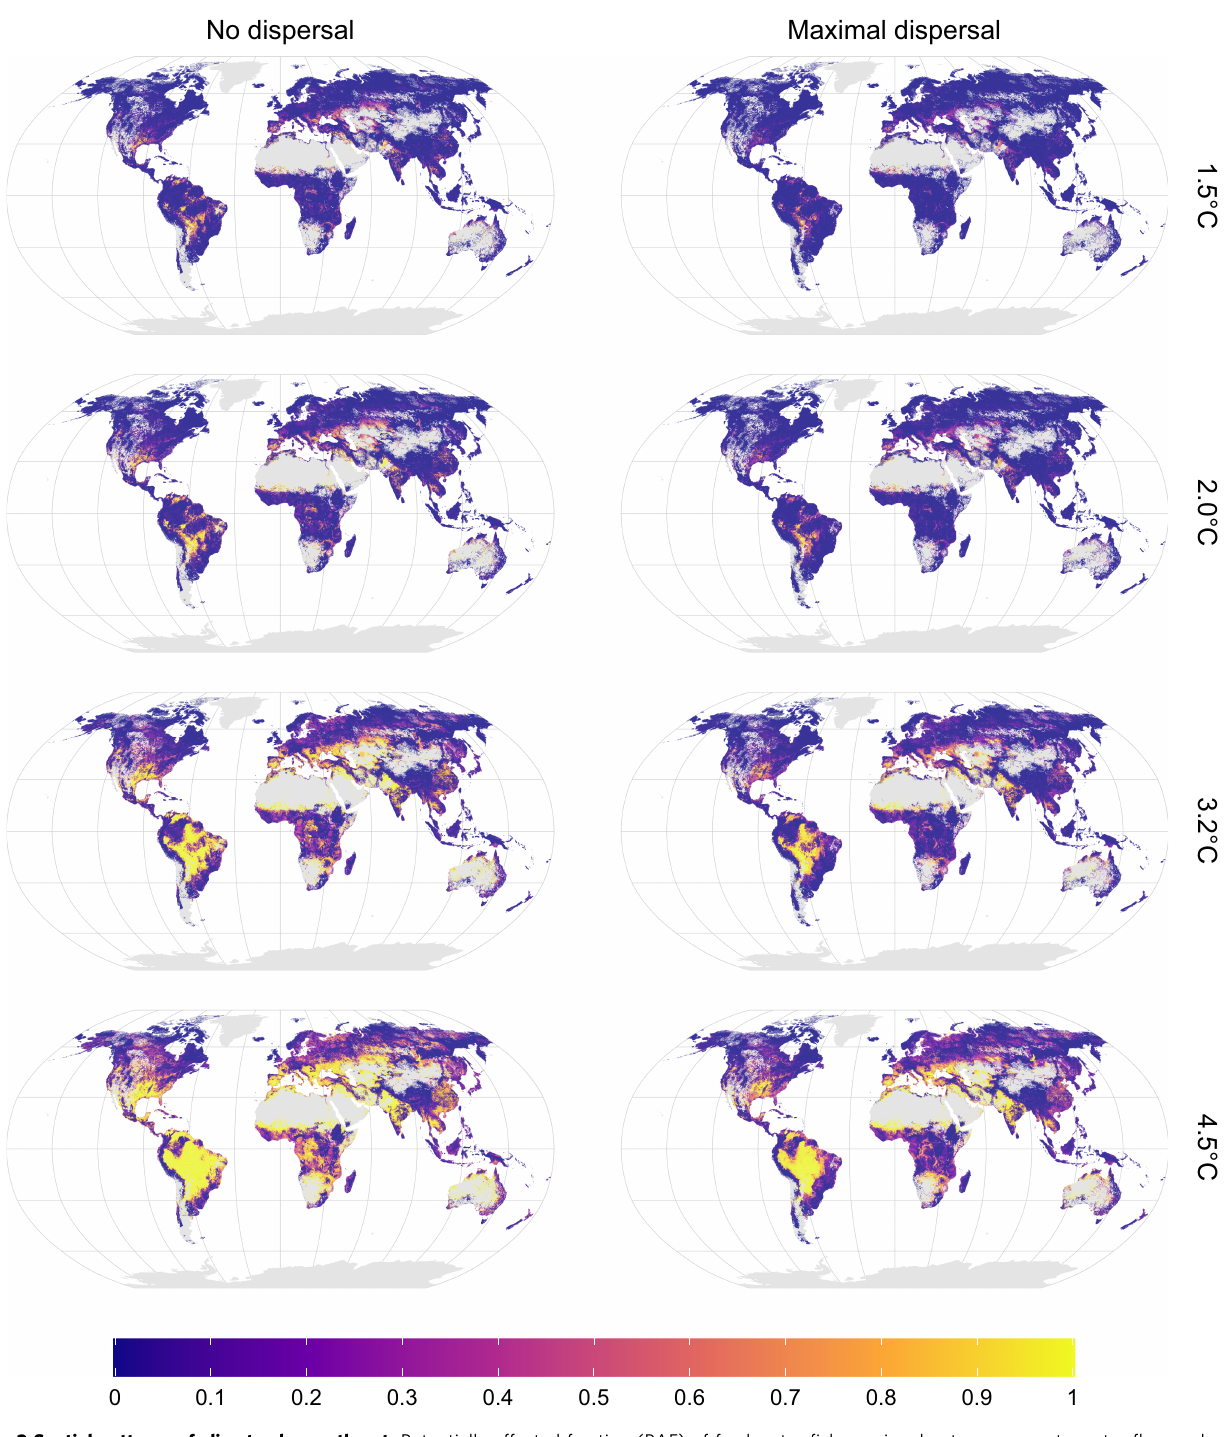
Fig. 2 Spatial patterns of climate change threat. Potentially affected fraction (PAF) of freshwater fi sh species due to exposure to water fl ow and temperature extremes beyond current levels, for different global warming levels and two dispersal assumptions. Patterns are based on the median PAF across the GCM – RCP combinations at a fi ve arcminutes resolution (~10 km). Gray denotes no data areas (no species occurring or no data available). Source data are provided as Supplementary Data 2 and